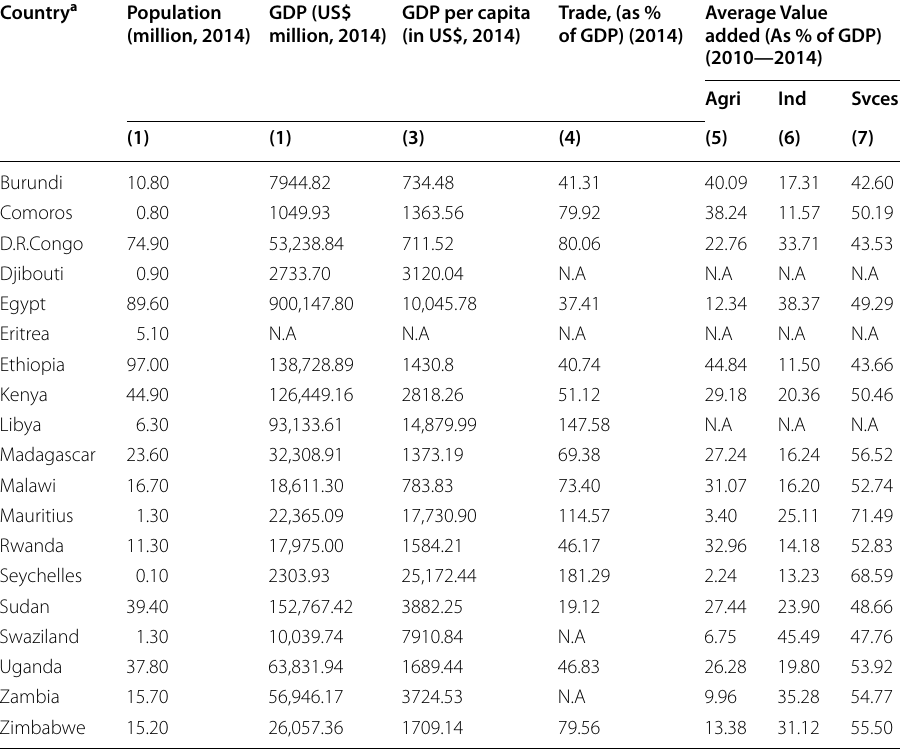
a The EPA is a reciprocal free trade agreement between African Caribbean, and Pacific (ACP) countries and the EU, and Ethiopia is currently negotiating with the EU to sign the interim-EPA